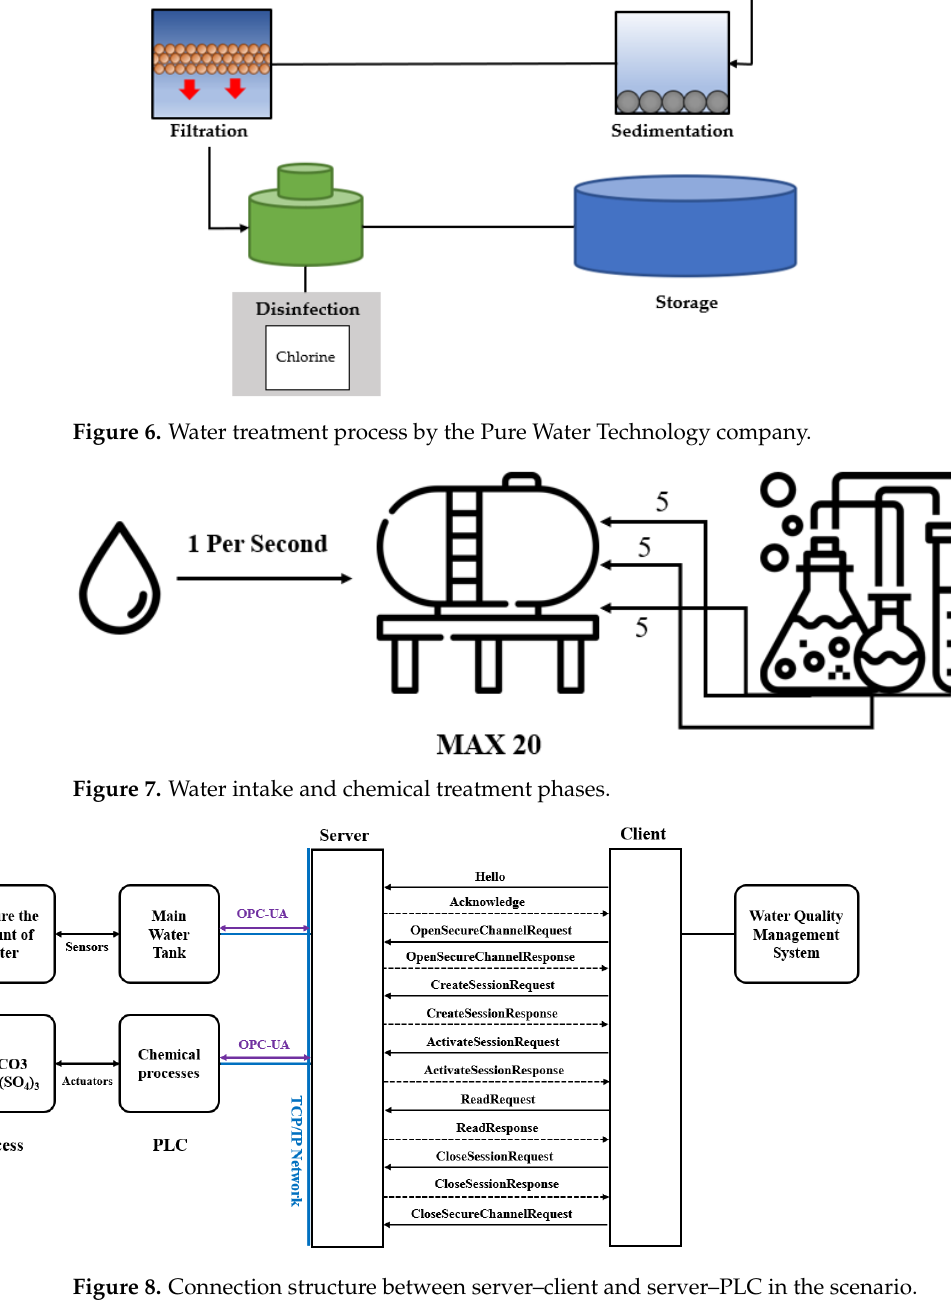
Figure 8. Connection structure between server–client and server–PLC in the scenario. The OPC technology consists of a server and client. Therefore, to implement an envi- ronment that includes the OPC, it is necessary to implement a server and client. Table 10 lists the open-source implementations of the OPC UA. Table 10. OPC UA open-source implementation list. No.